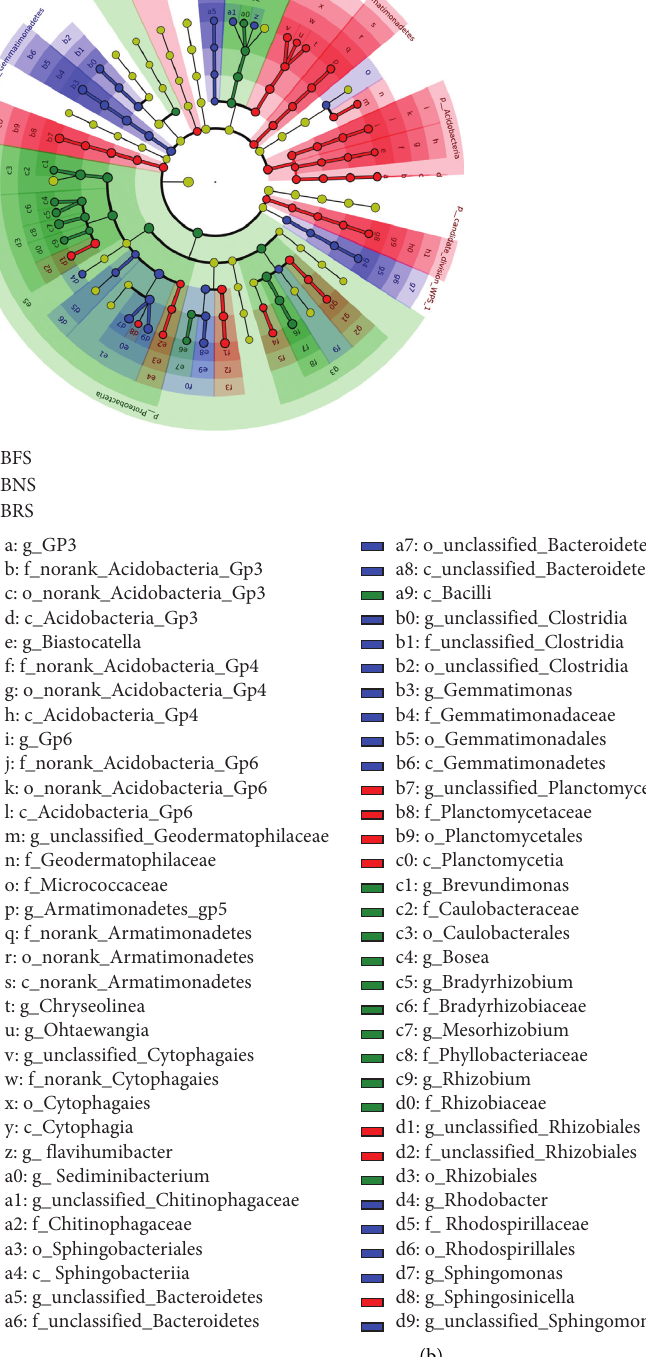
Figure 5: LEfSe results revealed bacteria biomarkers that were sensitive to growth substrate of mosses or bare soil at the genus level in two types of manganese waste residue areas. (a) The LEfSe of bacteria in mine waste slag areas. (b) The LEfSe of bacteria in electrolytic manganese slag